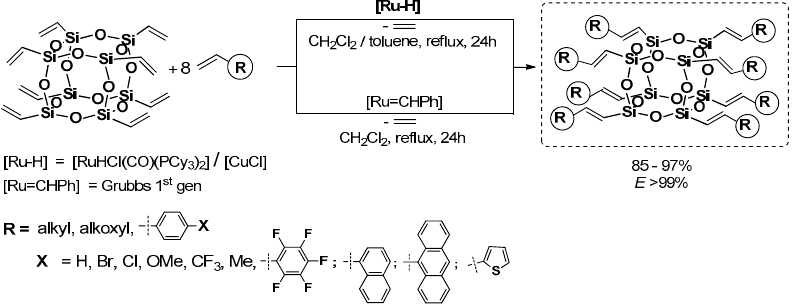
Figure 20. The silylative coupling vs. cross-metathesis leading to octa[( E )alkenyl]-substituted silsesquioxane T 8 .